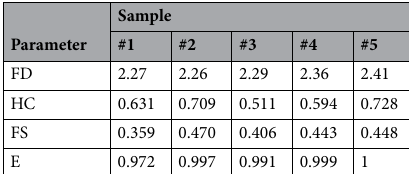
Table 4. Fractal parameters of the